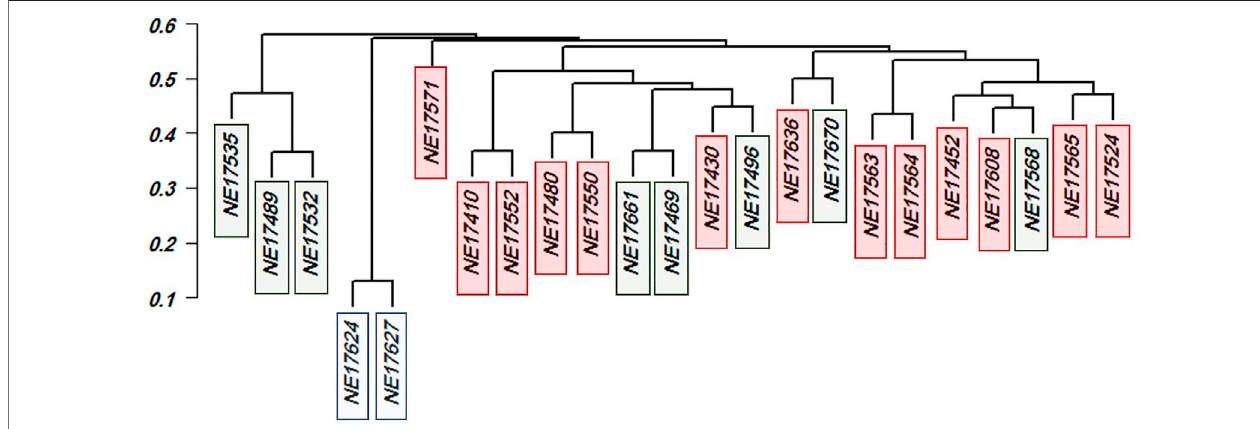
FIGURE7 | Dendrogram cluster and principalcomponent analysisfor the selecting 23selected genotypes withthe most forms ofresistance infections types. Red color refer to SPI, Green color refer to SP2 and Blue color refer to SP3.